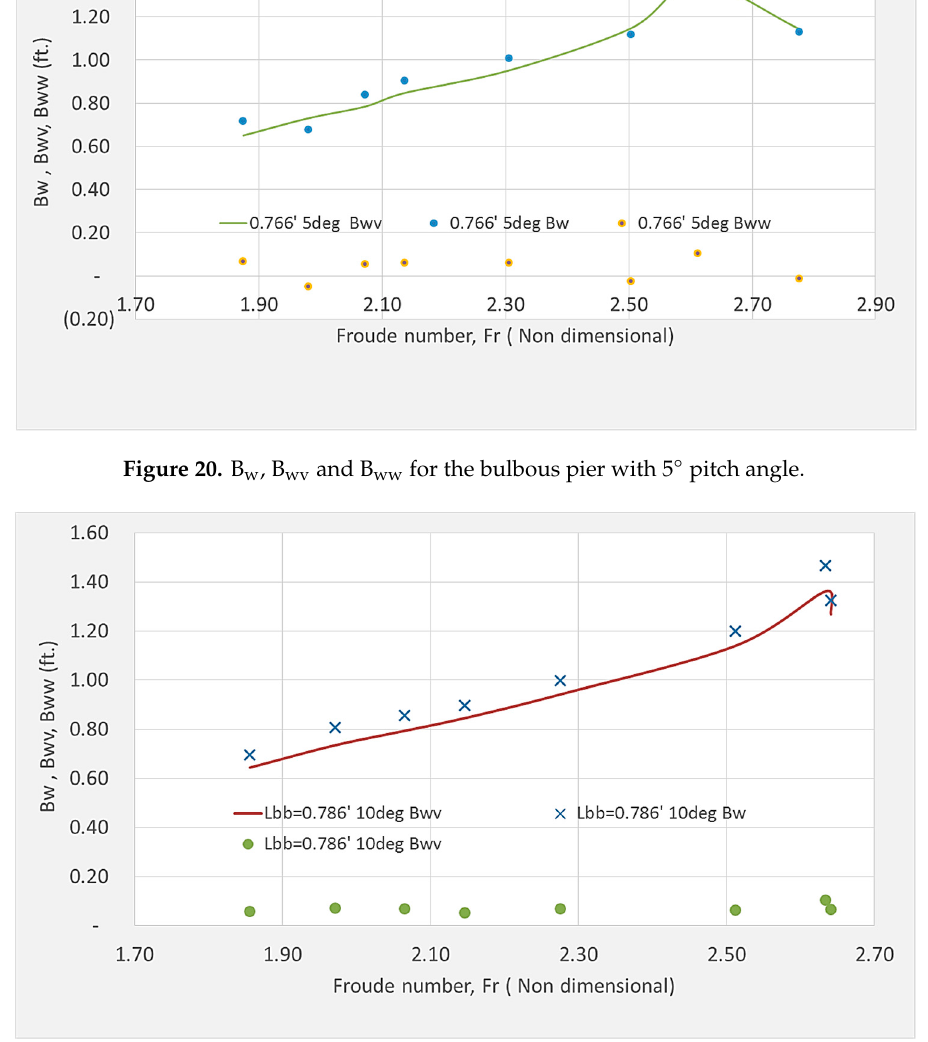
Figure 21. B wv and B ww for the bulbous pier with 10° pitch angle.